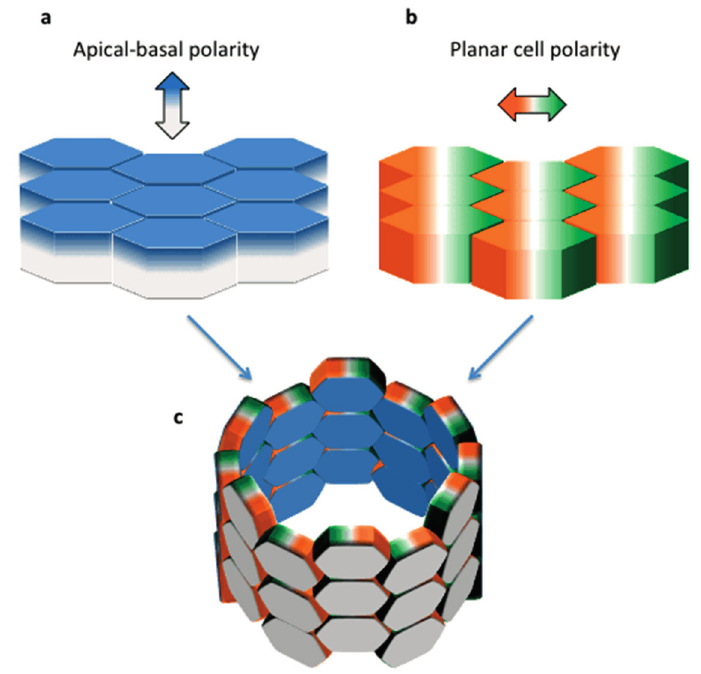
Figure 1. Apical-basal and Planar Polarity in Epithelia. Schematic representation of an epithelium, showing an apical-basal polarity along the vertical axis ( a ) and a planar cell polarity along the orthogonal axis ( b ); their appearance in association is shown in a tubular structure ( c